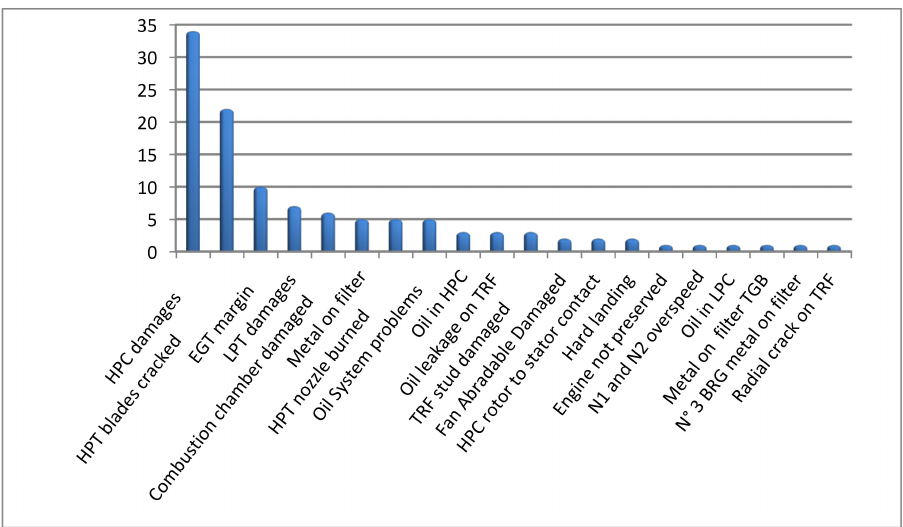
Figure 8. Engines unscheduled